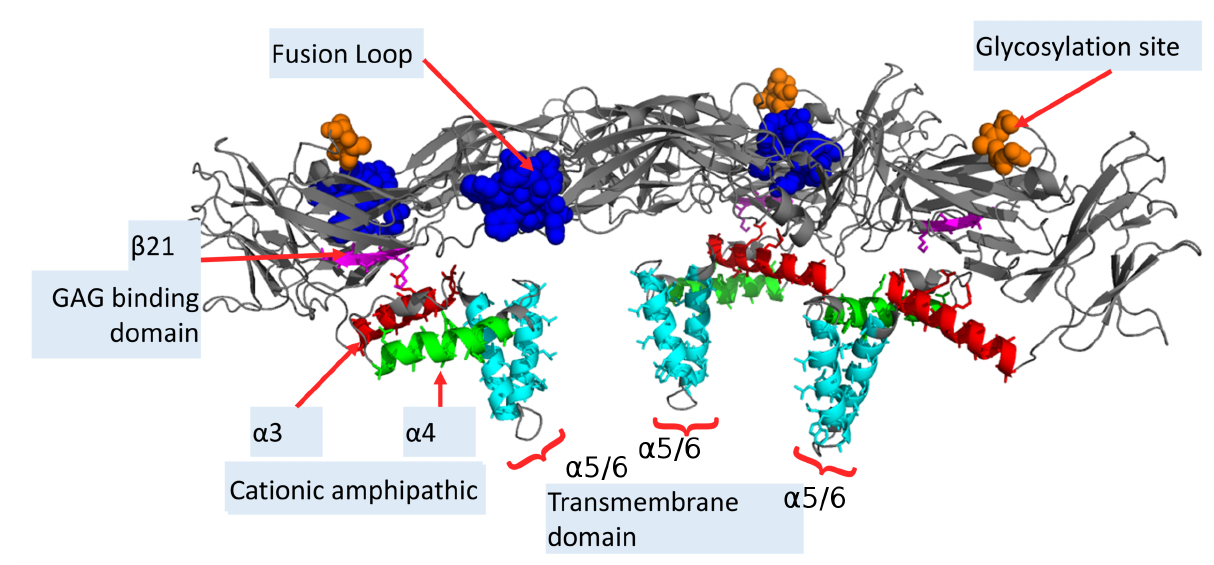
Figure 1. The structure of the ZIKA-E protein (PDB ID:5IRE). The E-proteins form a raft-like structure, in complex with the M-proteins (not shown here). Most common exposed residues are the highly conserved fusion loop (residues 98-109 in blue), the glycosylation site (Asn154 in ZIKV, in orange), and the GAG-binding domain which consists of a cationic β -sheet (in magenta). The stem region consists of cationic amphipathic helices α 3 and α 4 in the E proteins in red and green, respectively. The hydrophobic transmembrane helices α 5 and α 6 are in